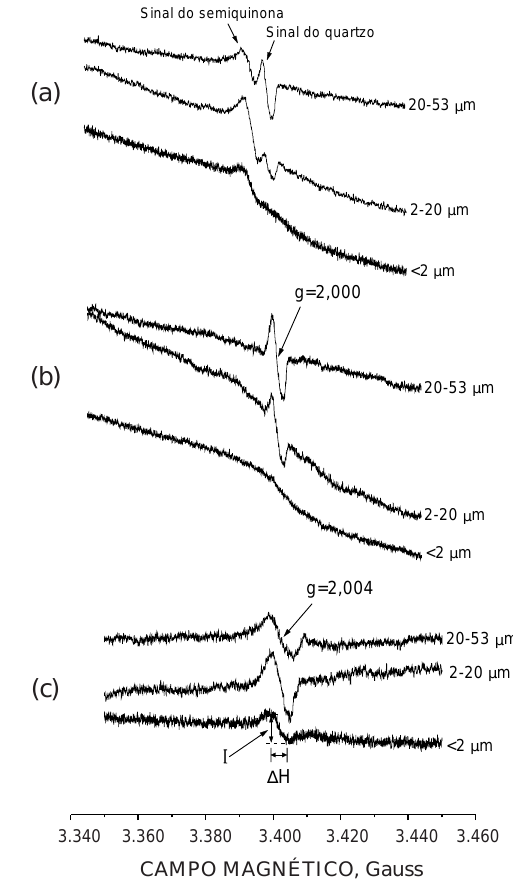
Figura 1. Espectros de EPR dos agregados organomine- rais do Podzólico Vermelho-Escuro: (a) espectros das amostras sem tratamento; (b) espectros das amostras tratadas com peróxido de hidrogênio; (c) espectro resultante da subtração dos espectros de (a) e de (b). I é a intensidade do sinal e DDDDD H é a sua largura de